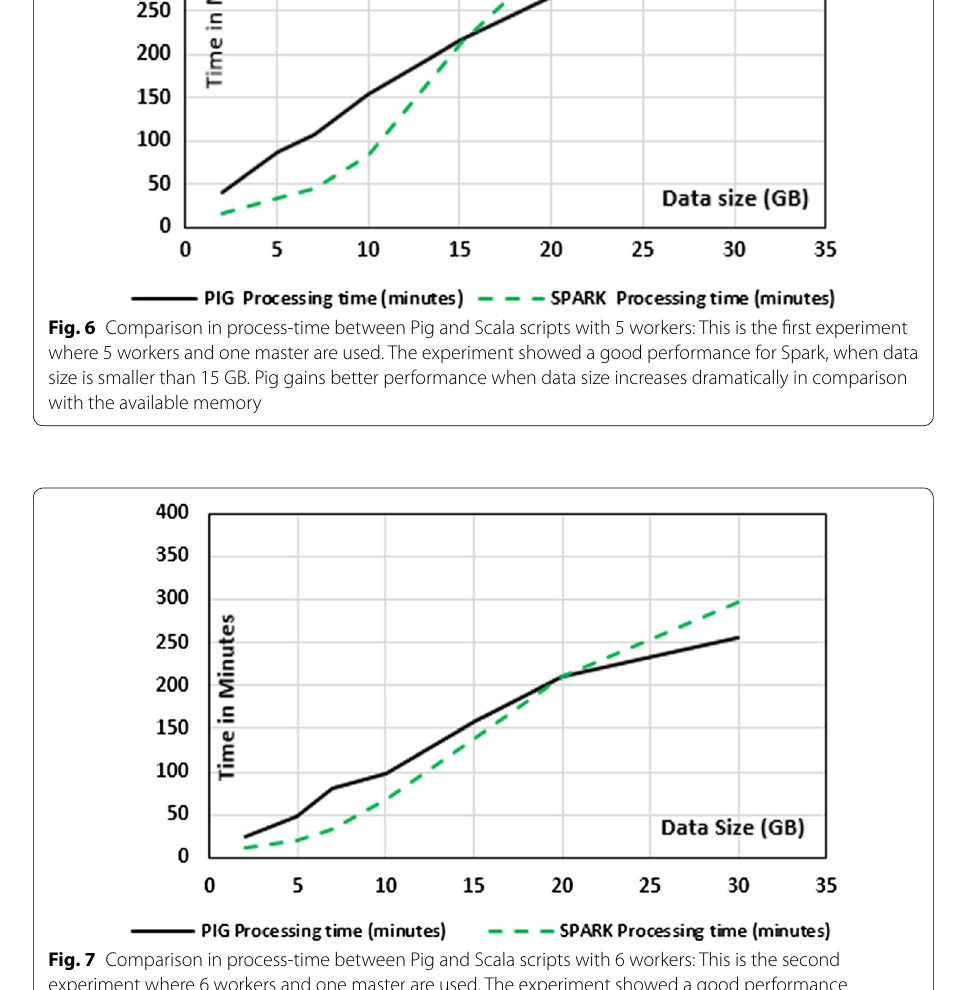
comparison with the data size. For instance, when data size 350 min.